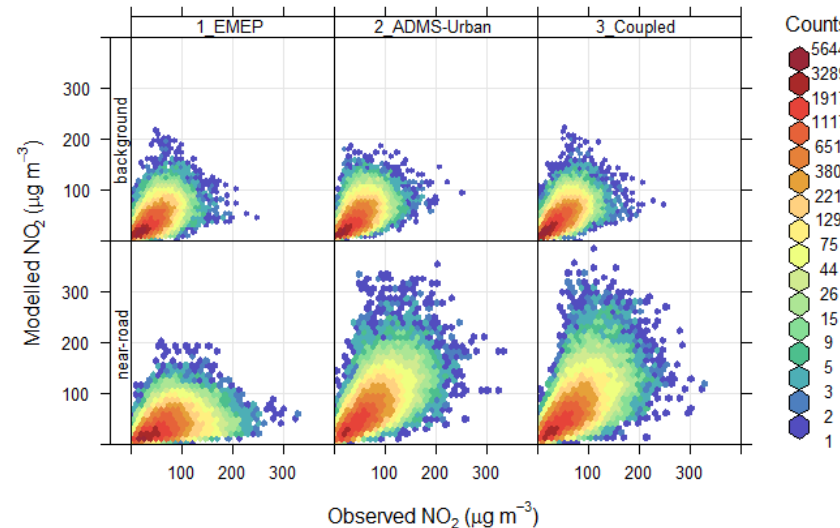
Figure 11. Frequency scatter plots for each model and site type showing the distributions of hourly average modelled and observed NO 2 concentrations (for sites where O 3 is also measured), where the colour represents the density of points for a given combination of measured and modelled